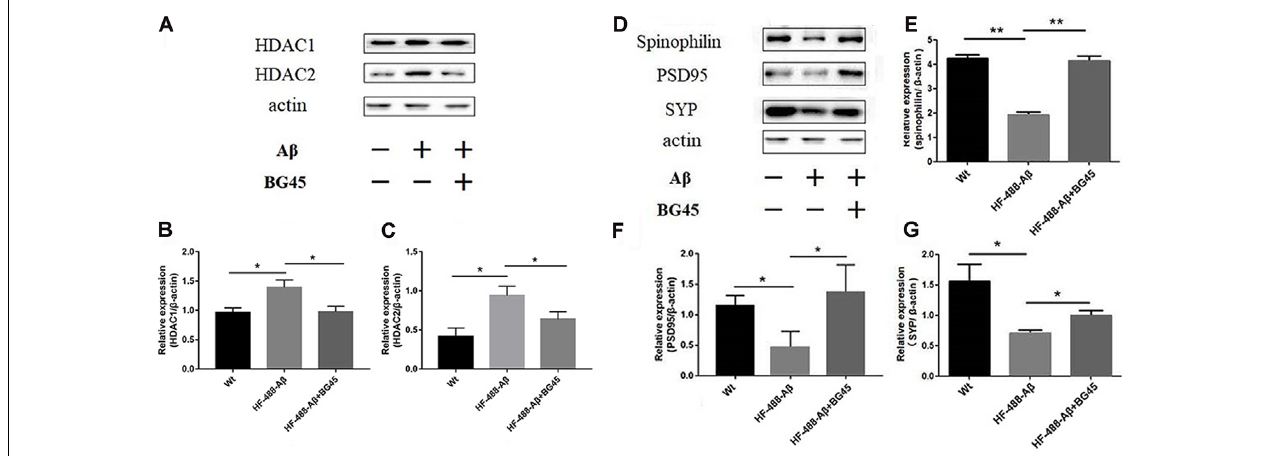
FIGURE 7 | Effect of BG45 on the expression of HDAC1, HDAC2, synaptic-related proteins after the HF-488-A β 1–40 treatment. (A) Representative bands of the expression of HDAC1 and HDAC2 from control mice, HF-488-A β group and HF-488-A β + BG45 group. (B,C) Quantification of HDAC1 and HDAC2 is normalized to β -actin and is shown as a % of control. The expression of HDAC1, 2 was increased in the HF-488-A β group. Compared with the HF-488-A β group, the expression was significantly decreased in the HF-488-A β + BG45 group. (D) Representative bands of the expression of synapse-related protein from the control group, HF-488-A β group, and HF-488-A β + BG45 group. (E–G) Quantification of spinophilin, PSD-95, and synaptophysin (SYP) is normalized to β -actin and is shown as a % of control. The expression of spinophilin, PSD-95, and SYP was significantly decreased in the HF-488-A β group compared with the control group, while was improved in the HF-488-A β + BG45 group. n = 5. * p < 0.05, ** p <